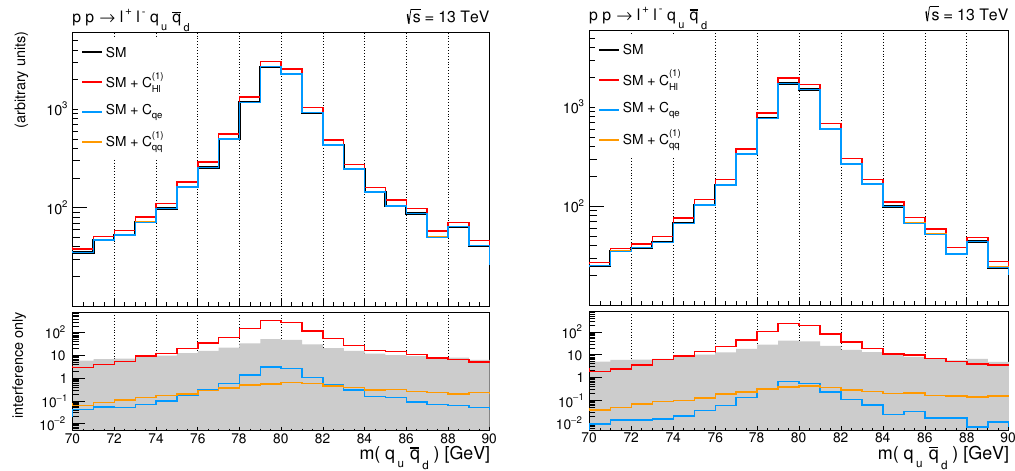
Figure 7 . Invariant mass spectrum of the q u (cid:22) q d pair in process (iii) before (left) and after (right) applying a narrow selection cut on m ( ‘ + ‘ (cid:0) ) to isolate the Z peak. The top panels show the complete distributions obtained in the SM limit and in the presence of one e(cid:11)ective operator with C i = (cid:3) 2 = 1 TeV (cid:0) 2 (only the interference term is retained in these cases). The black, yellow and blue lines are overlapping in both (cid:12)gures. The lower panels show the absolute size of the pure SM{ interference term for each operator (colored lines) compared to the statistical uncertainty on the SM distribution (grey